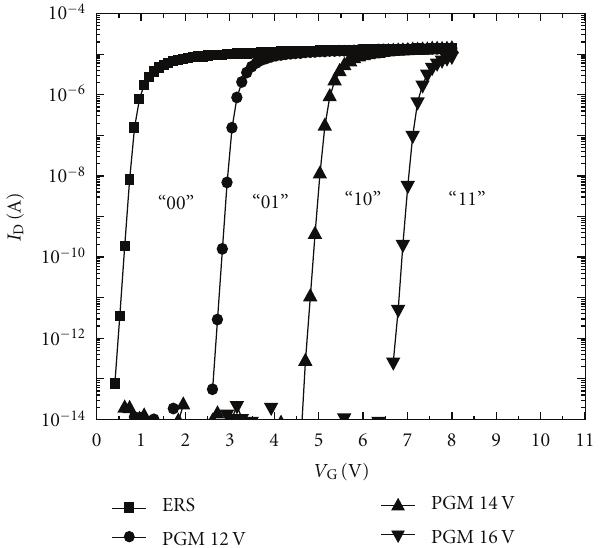
Figure 15: Multibit programming characteristics of JL-SONOS memory with a gate biases of 12, 14, and 16 V for 1 ms. Wire diameter = 20nm, channel doping = 1 × 10 19 /cm − 3 . (Reprinted with permission from [45]. [2011] IEEE.)